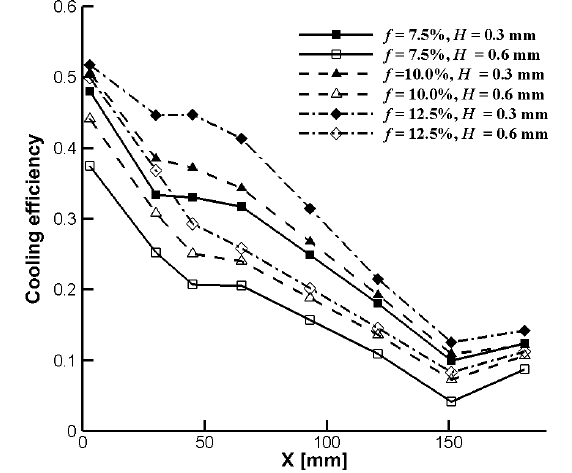
Figure 9. Cooling efficiency along the axial direction for θ = 6.37°.